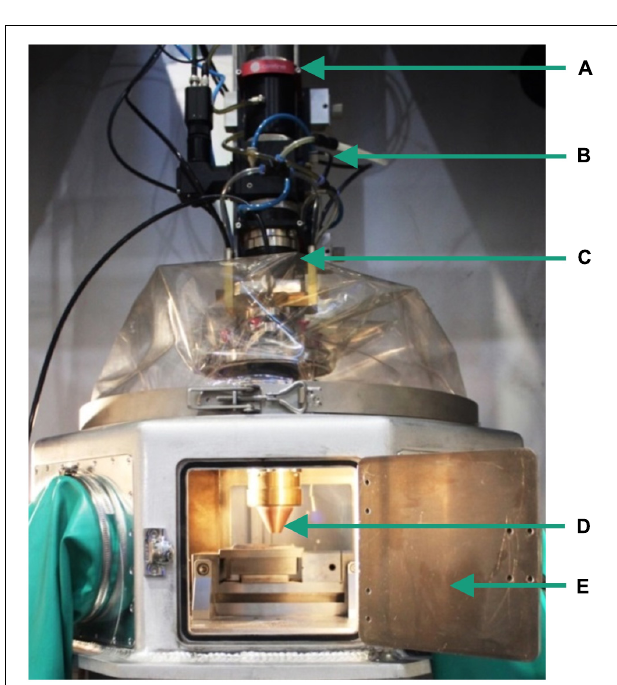
FIGURE 2 | Laser Metal Deposition (LMD) test assembly: (A) fiber plug; Laser LDM4000-100, Laserline GmbH; (B) Powder inlets; (C) OTS-2-optic with laser-focus of 3.8 mm; (D) Powder-nozzle COAXpowerline with powder-focus of 1.9–2.2 mm; and (E) Shielding gas chamber with Ar (O 2 < 20